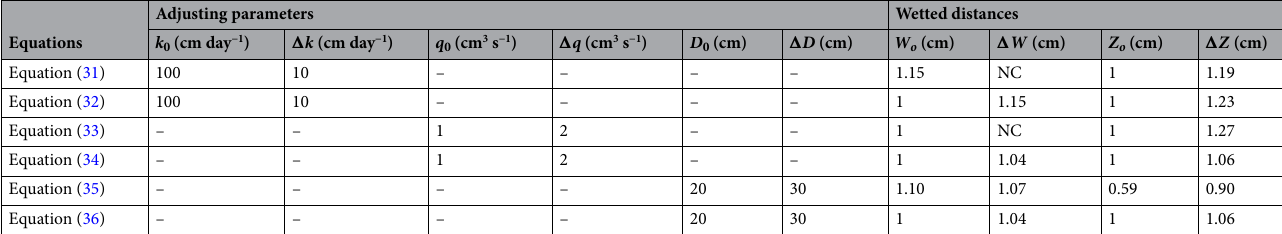
Table 6. Sensitivity analysis evaluation of W and Z to model parameters. k o initial hydraulic conductivity, (cid:31) k order of magnitude incremental hydraulic conductivity, q o starting discharge, (cid:31) q incremental discharge, D